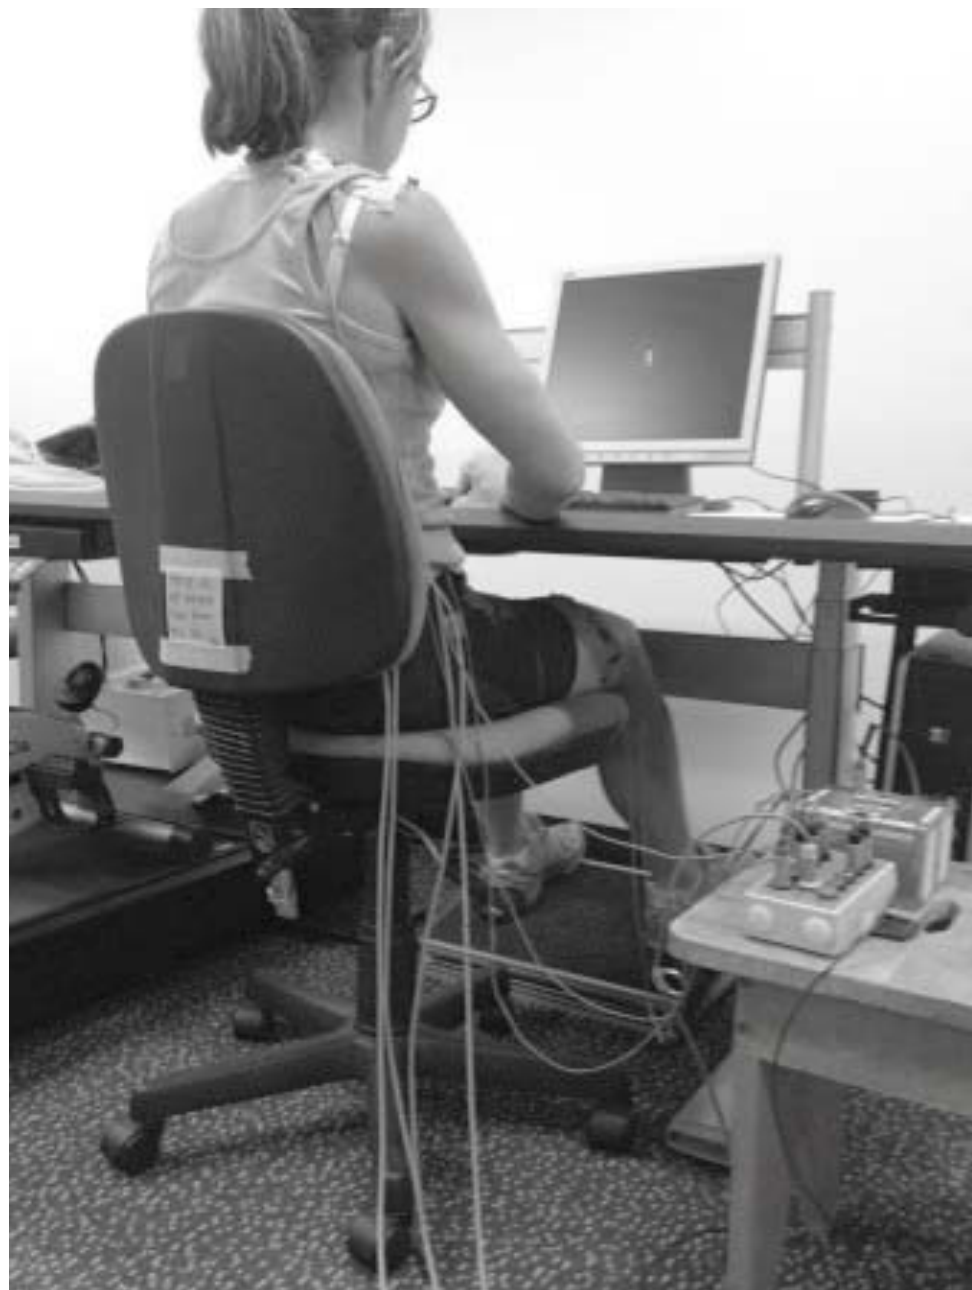
Figure 1. Work position of participants.